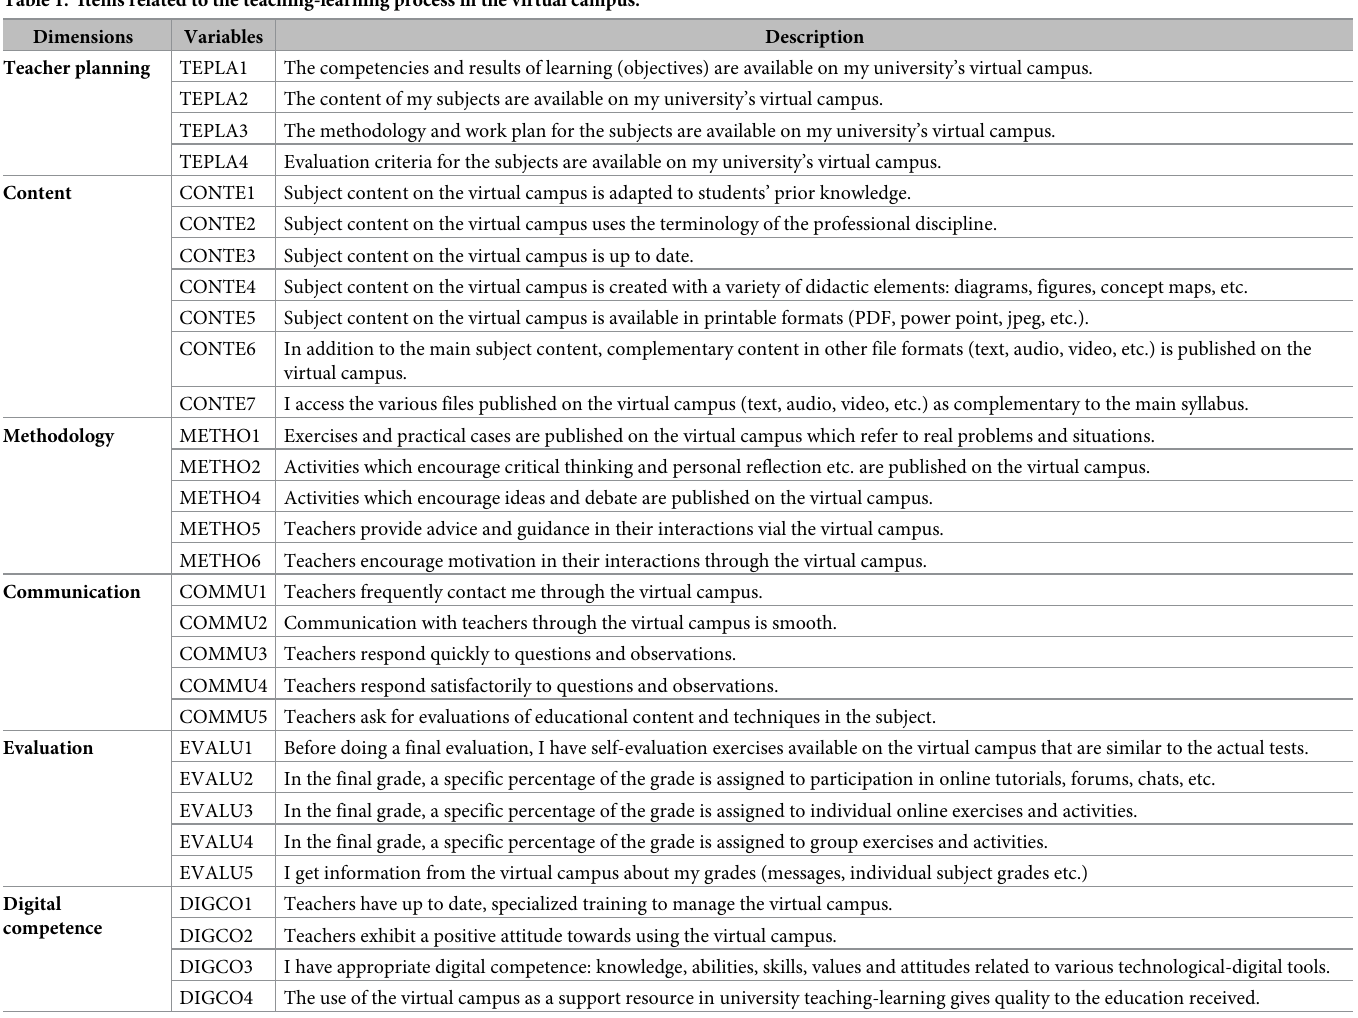
Table 1. Items related to the teaching-learning process in the virtual